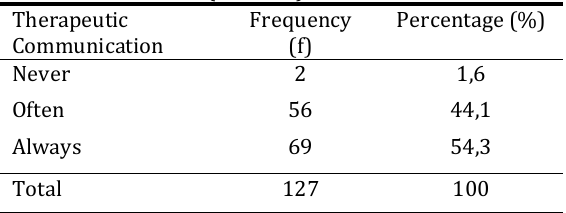
Table 3 Frequency Distribution of Respondents Based on Therapeutic Communication in the